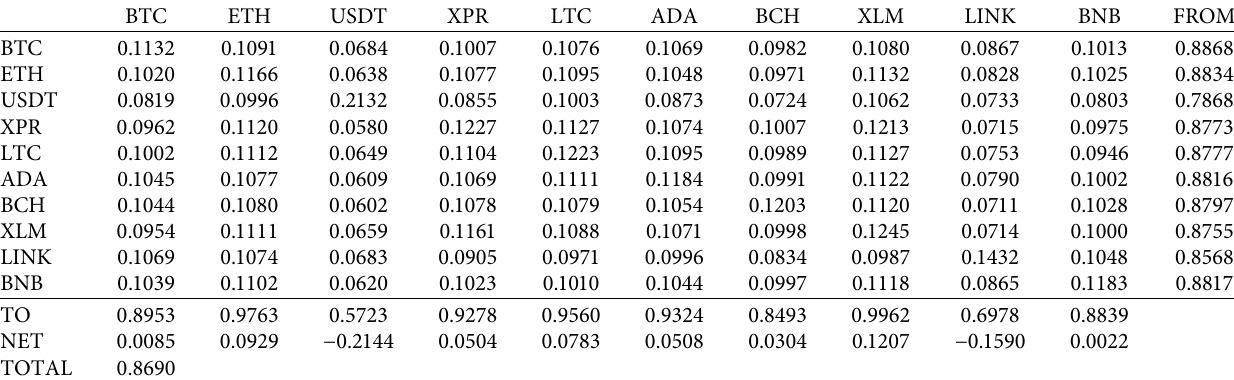
Table 6: Total, net, and pairwise spillovers among cryptocurrencies post-COVID-19 (return spillovers).